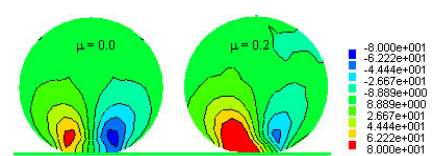
Fig. 9. Distribution of shear stress at t =